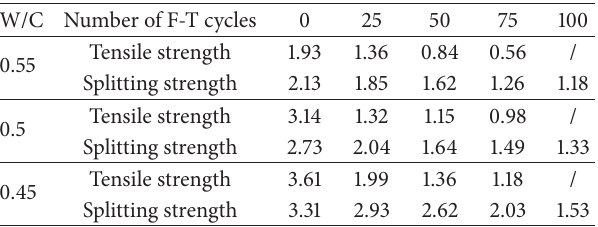
Table 5: The splitting and tensile strength of plain concrete after F-T cycles (MPa).